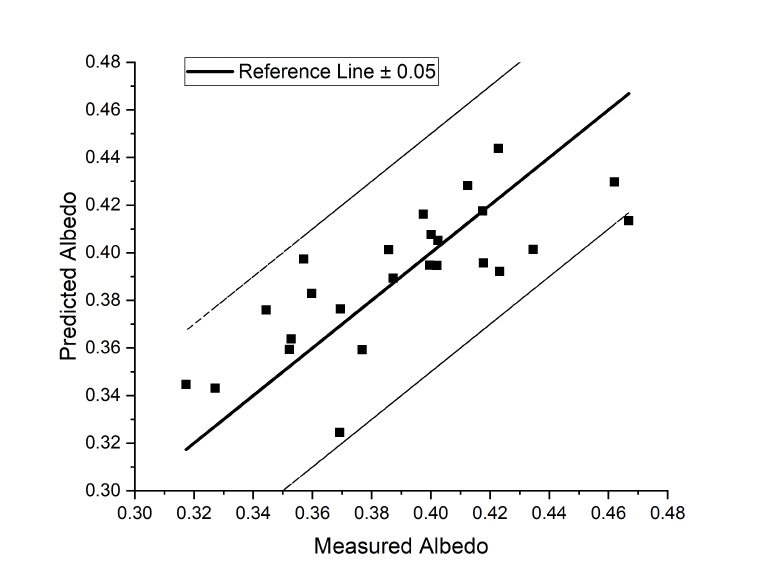
Figure 7. Comparison of measured and predicted albedo from laboratory specimen